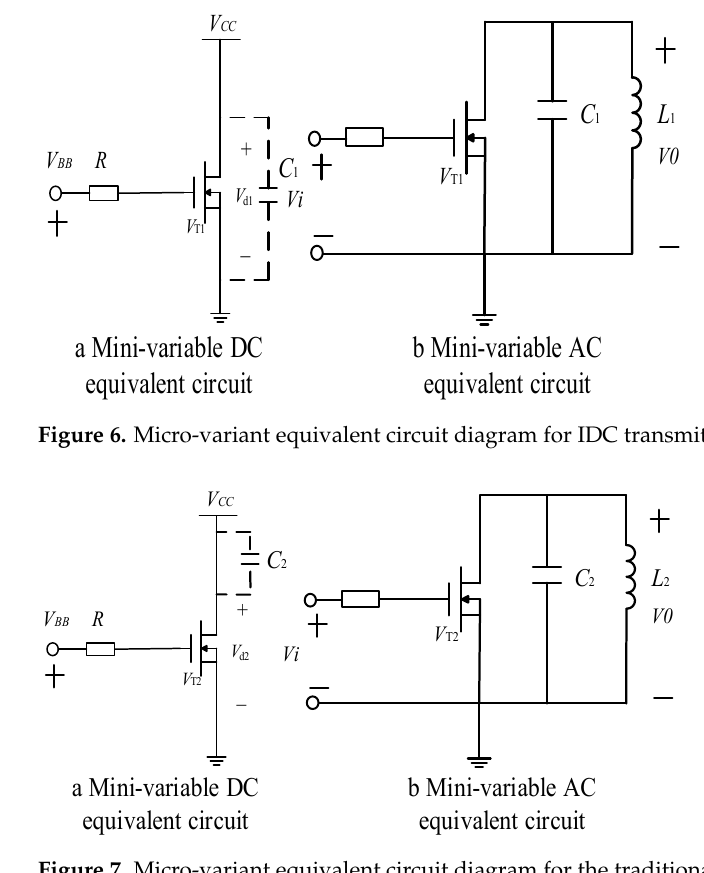
Figure 7. Micro-variant equivalent circuit diagram for the traditional transmitter.